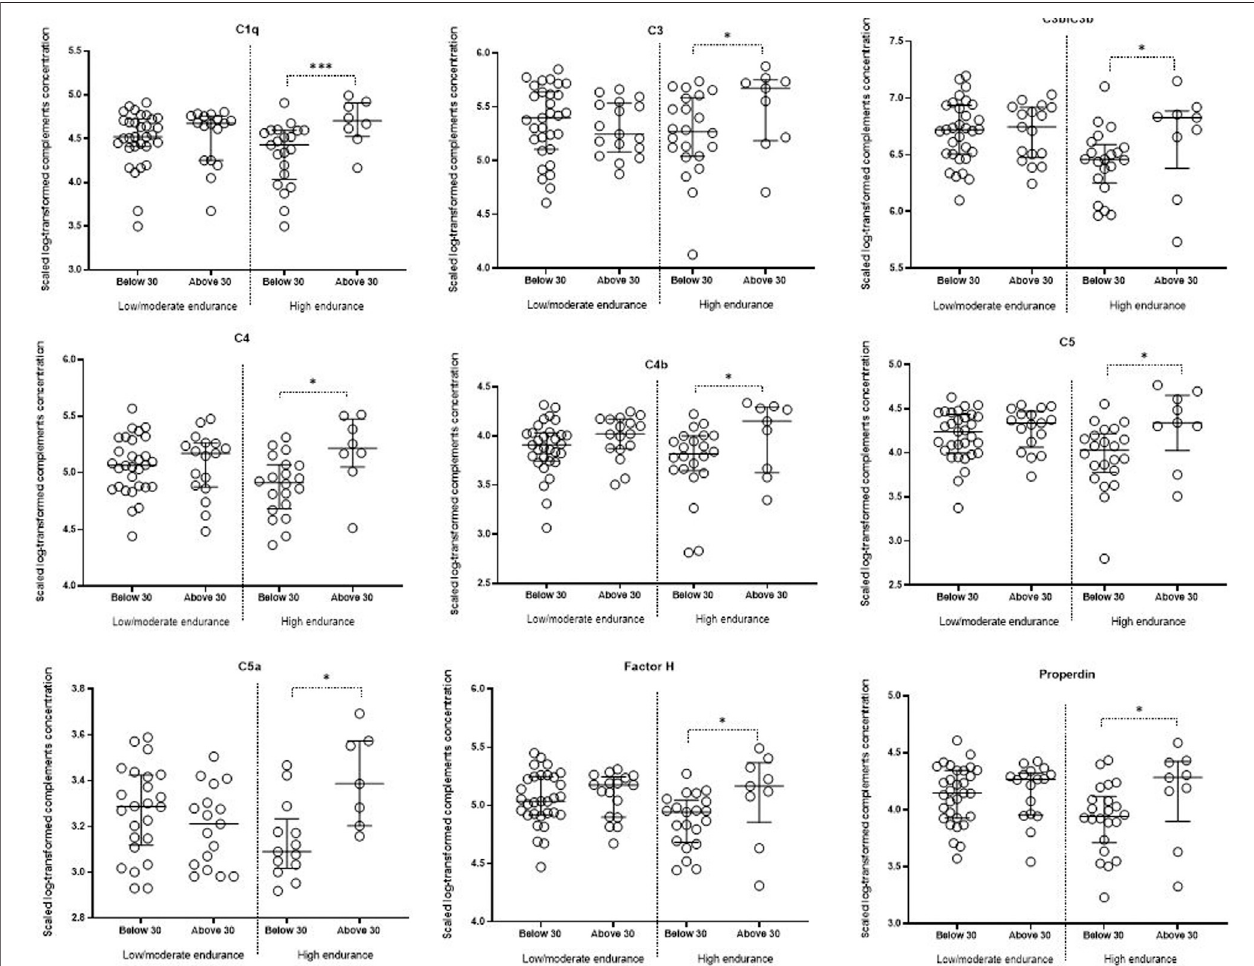
FIGURE3| Comparingcomplementsbetweendifferentagegroupsinlow/moderateandhighenduranceeliteathletes.Linearmodelsincorporatingtheinteraction term (age versus sport intensity), followed by contrast analysis, were used to compare scaled log-transformed cytokine levels ( y axes) in different sport intensity groups. Data are presented as median and IQR. * <